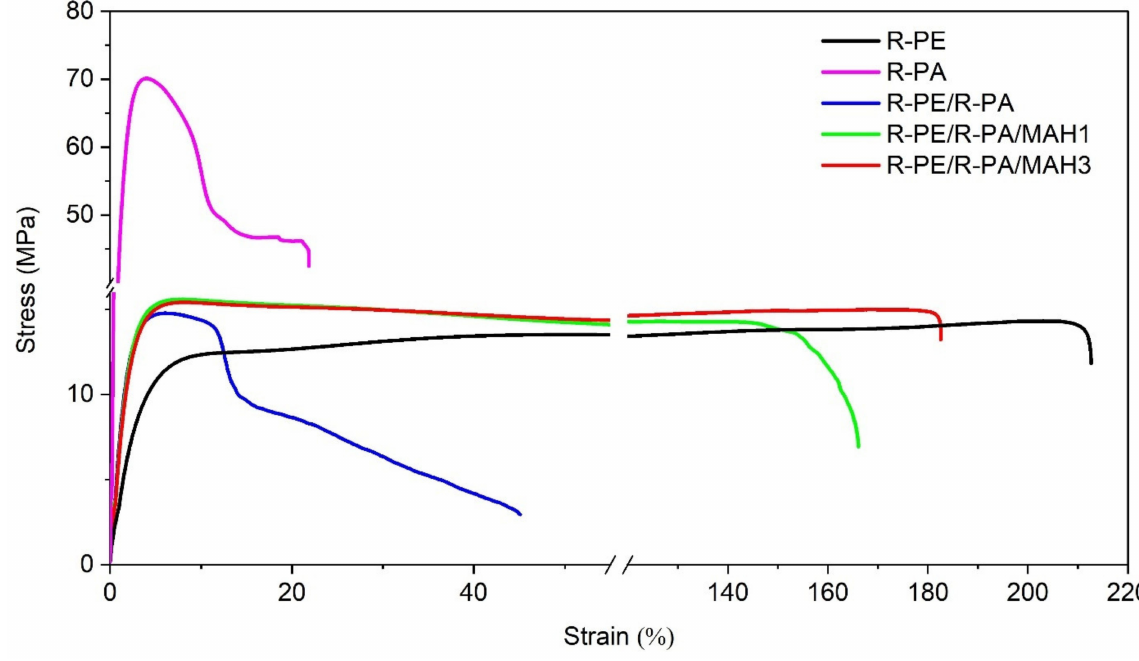
Figure 6. Stress–strain curves of R-PE, R-PA, and R-PE/R-PA blend with varying compatibilizer content.